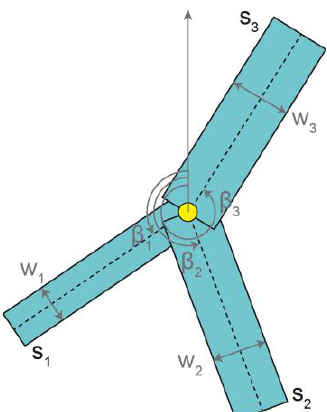
Figure 1. The object in our configuration is a junction point with n outgoing segments (here: n = 3). Each segment s j is characterized by its width w j and its direction β j (the counterclockwise angle relative to the positive